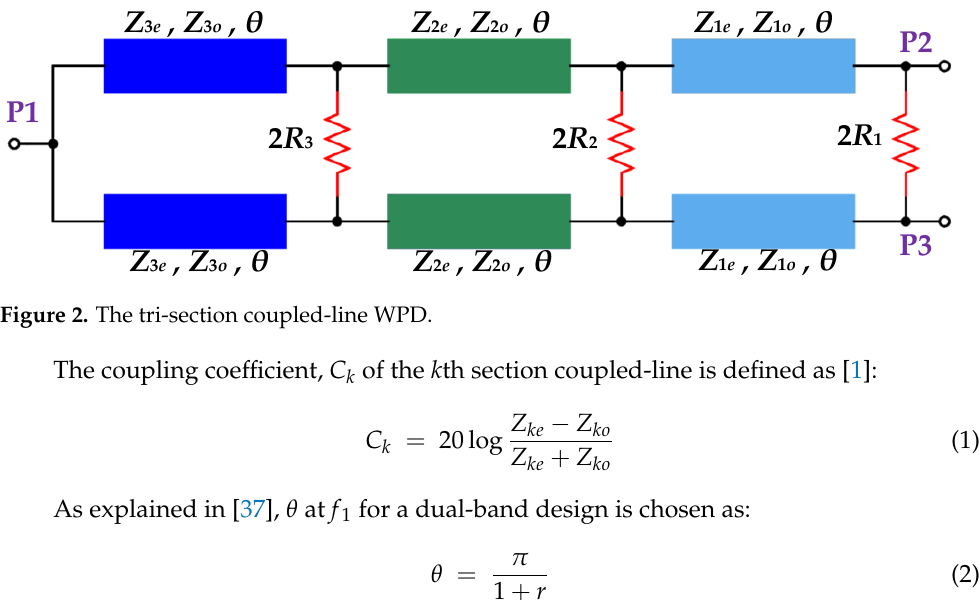
Figure 2 . The tri-section coupled-line WPD